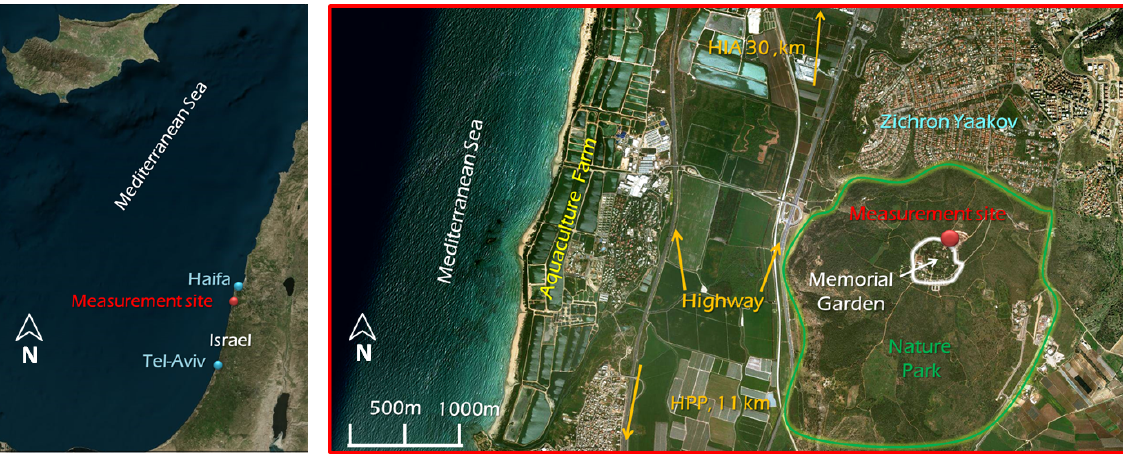
Figure 1. Satellite images of the measurement site at Ramat Hanadiv Nature Park. Left: location of the measurement site (red dot). Right: zoomed in image of the surrounding area of the measurement site (red dot). Background imagery from © Google